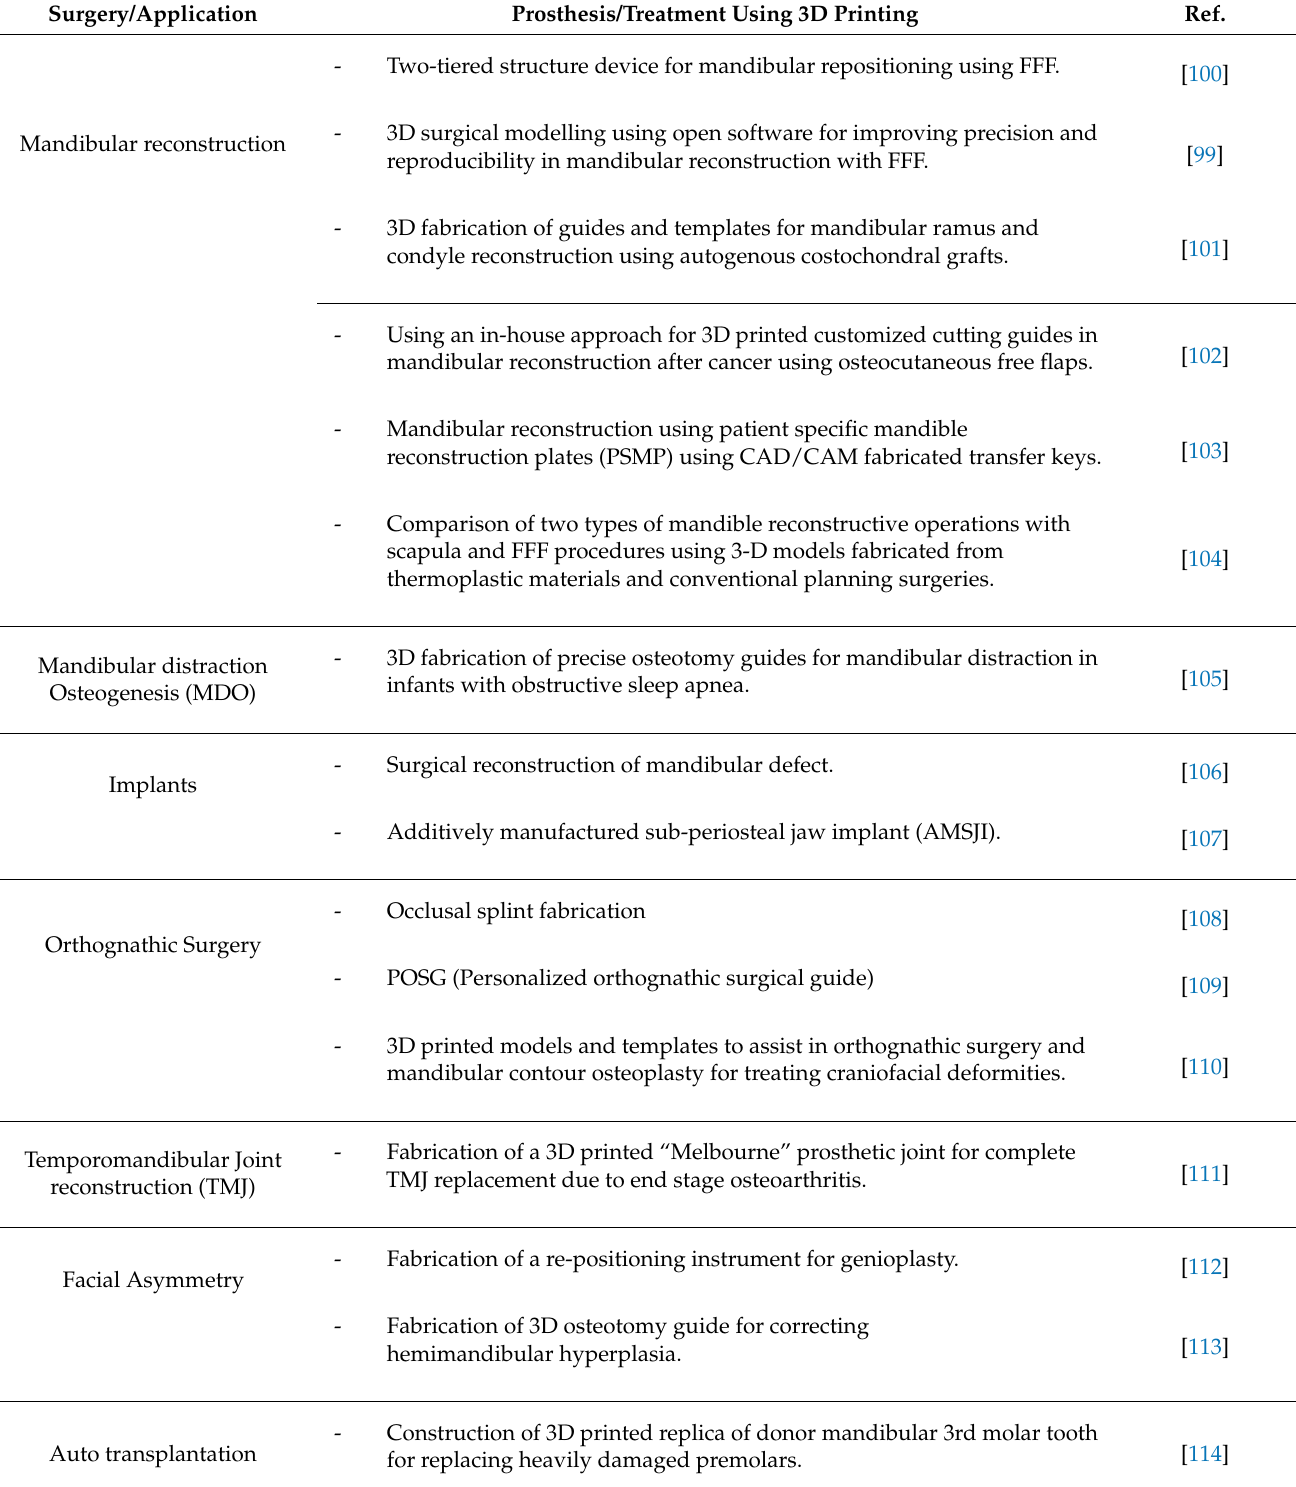
Table 3. Clinical studies using 3D printing for patient specific applications. Surgery/Application Prosthesis/Treatment Using 3D Printing Ref.